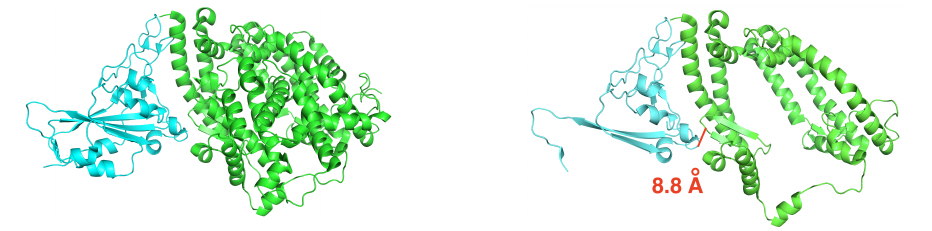
Figure 6. Truncation of SARS-CoV-2 S RBD used in the entropy estimate. The spike protein is in cyan, and the ACE2 receptor is in green. Left: original complex. Right: truncated complex. A pair of atoms on the binding interface that are 8.8 Å apart is shown in a solid red segment to illustrate the length scale.